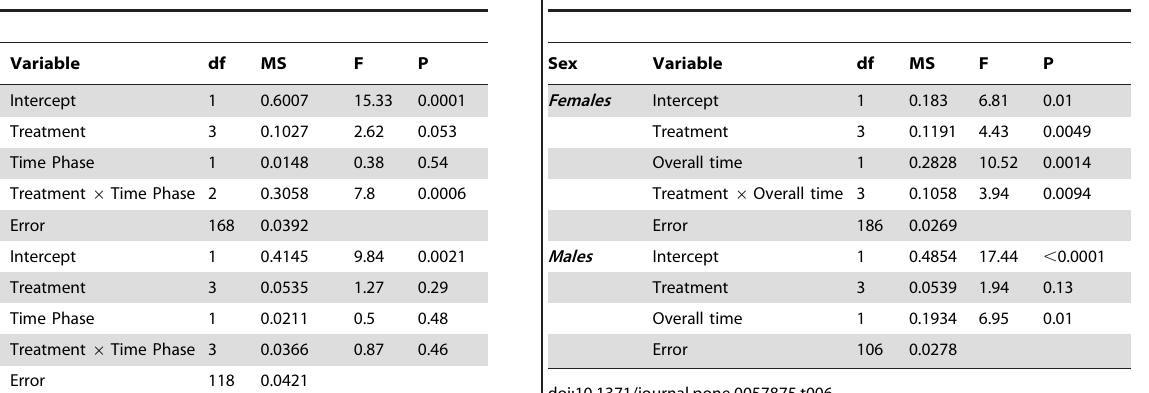
Table 5. ANOVA of the effect of treatment and time phase on O. caspius size.